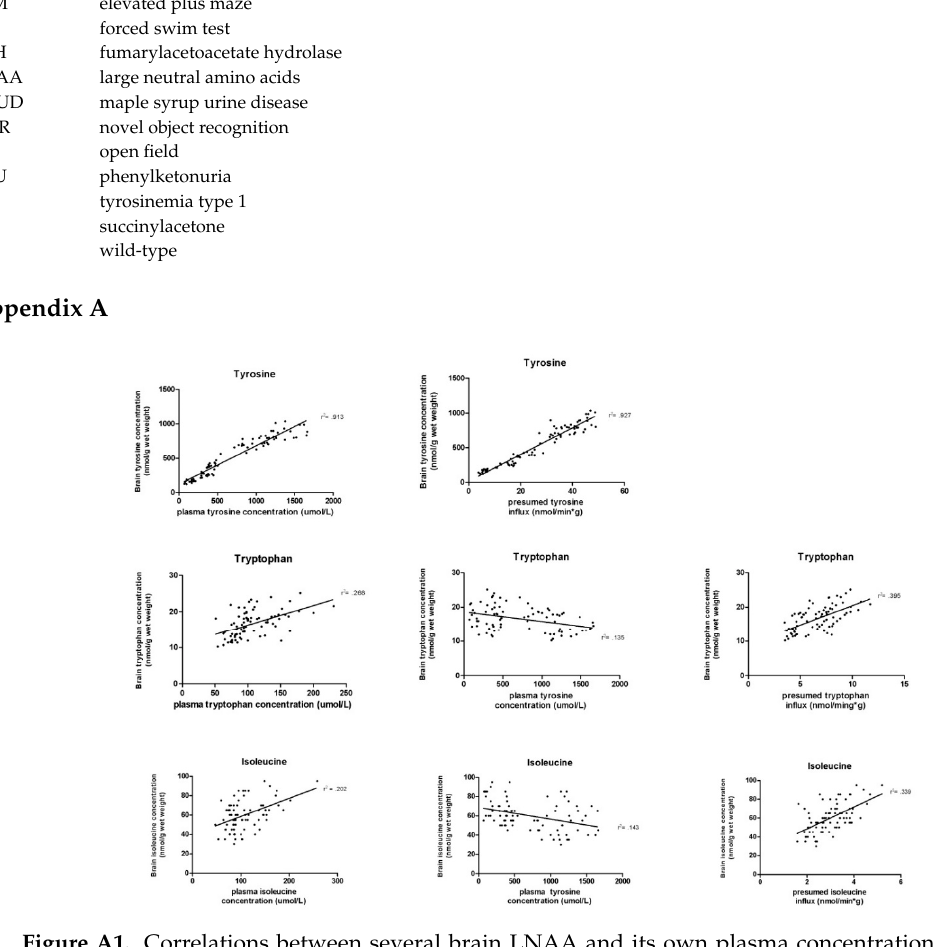
Figure A1. Correlations between several brain LNAA and its own plasma concentration, plasma tyrosine concentration and the calculated presumed brain influx. The different graphs show that most of the variance (displayed as R 2 ) is explained when the presumed brain influx is correlated to the brain LNAA concentration.